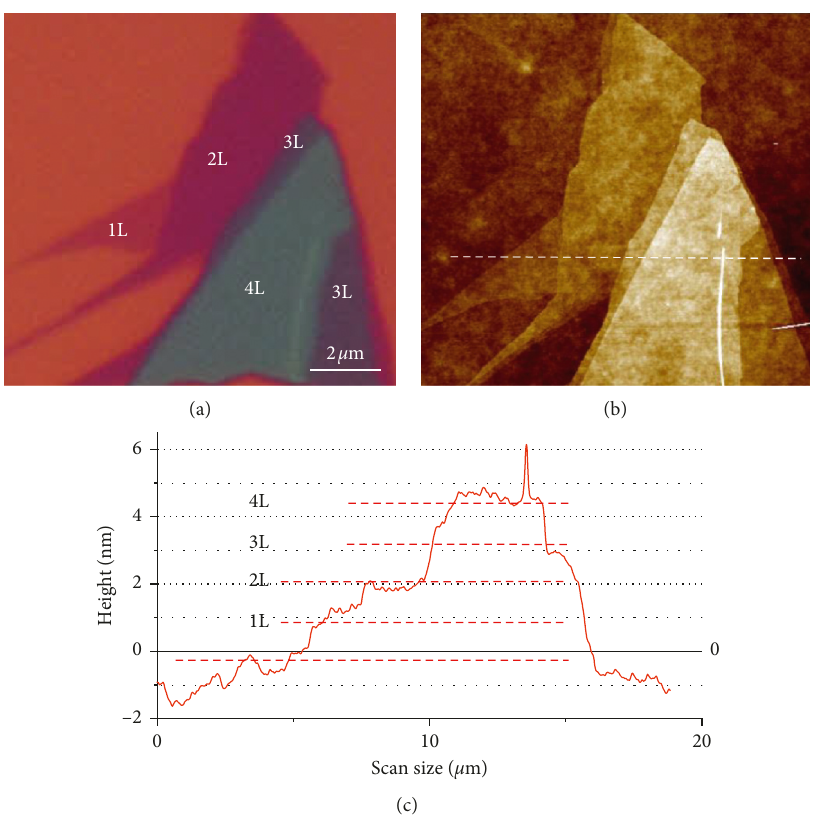
Figure 1: (a) Optical image and (b) atomic force microscope (AFM) image of 1–4L MoSe